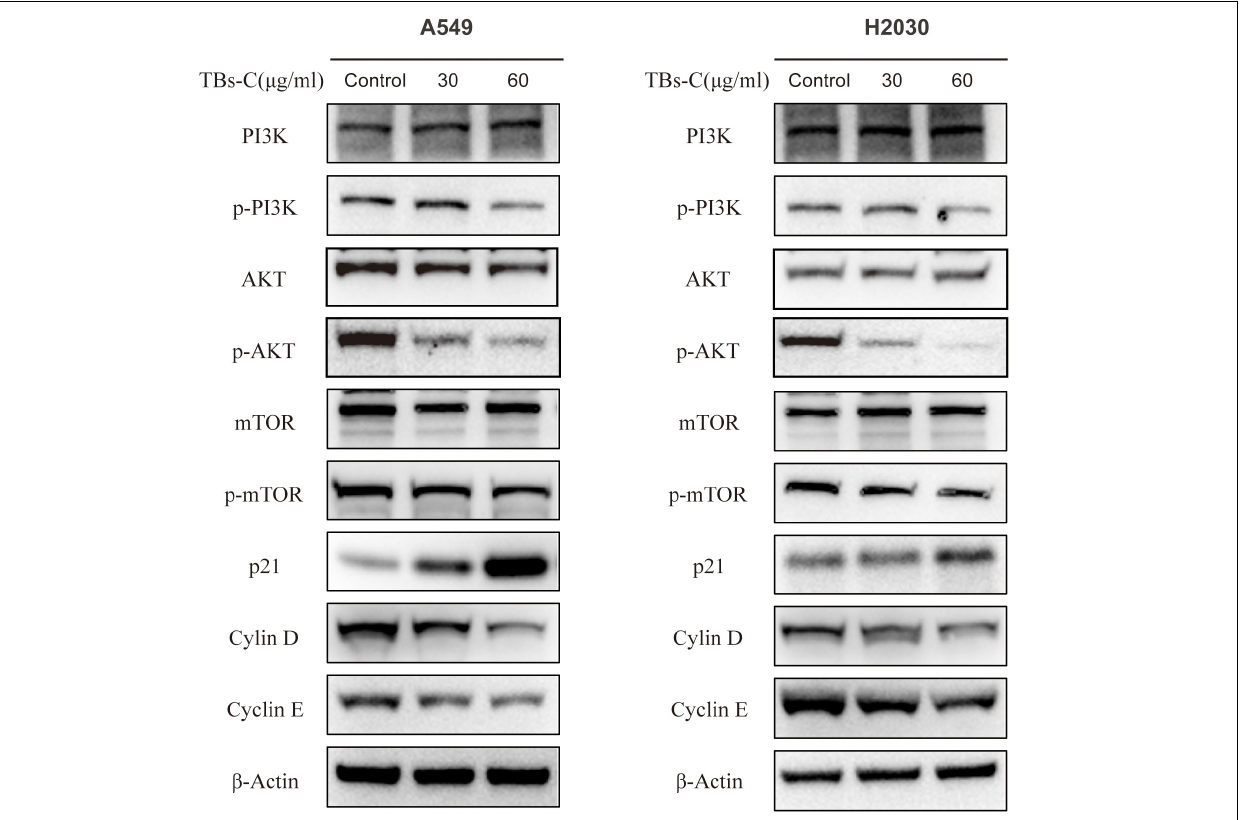
FIGURE 6 | TBs-C inhibits the PI3K/AKT/mTOR pathway in NSCLC cells. The expression of major proteins in the PI3K/AKT/mTOR pathway and the AKT/p21 signal axis was detected by Western blotting in cells treated with different concentrations of TBs-C, with β -actin was used as a